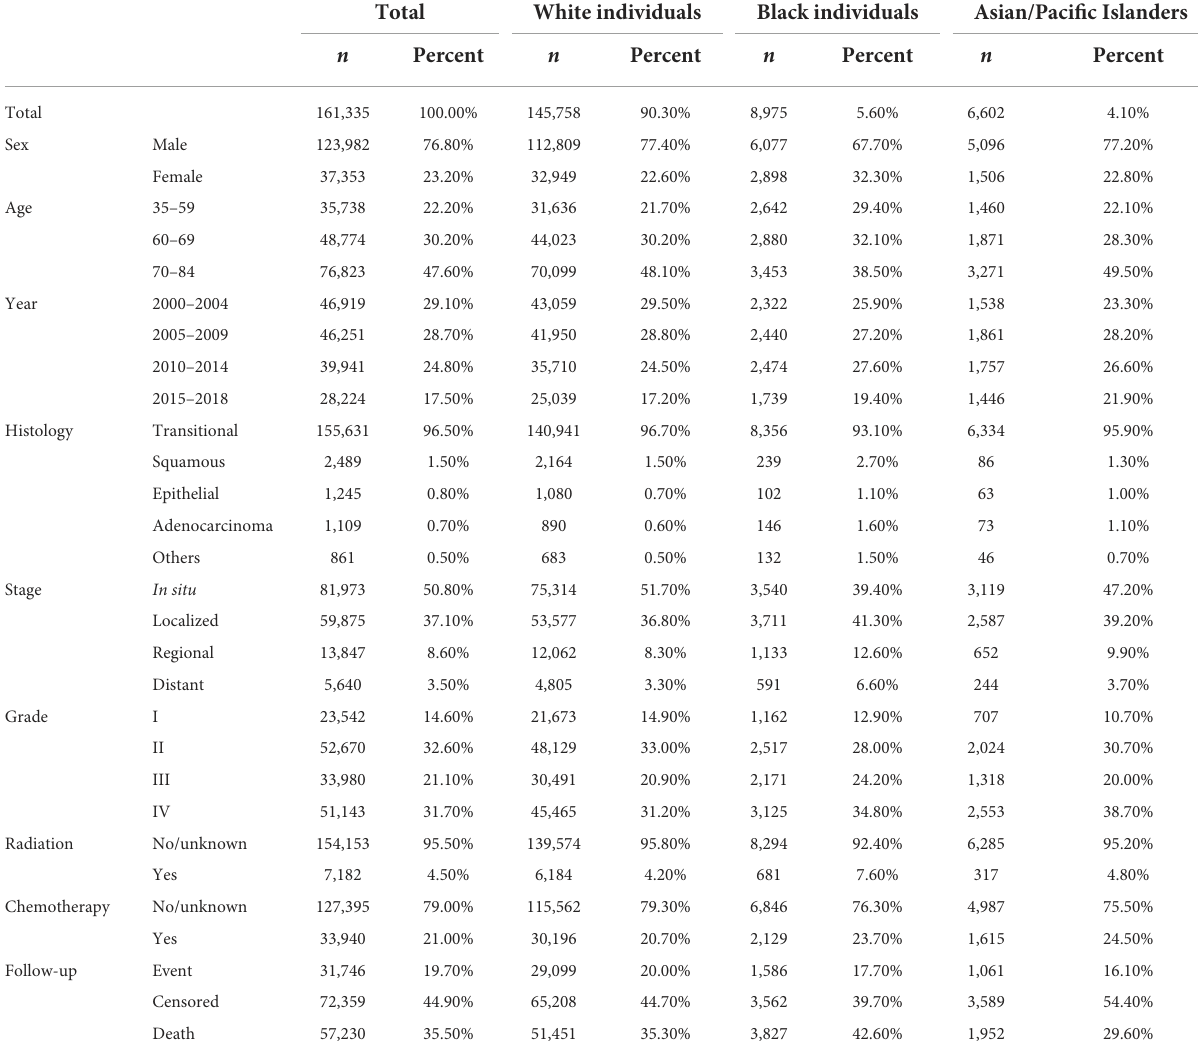
TABLE 1 Bladder cancer cases by